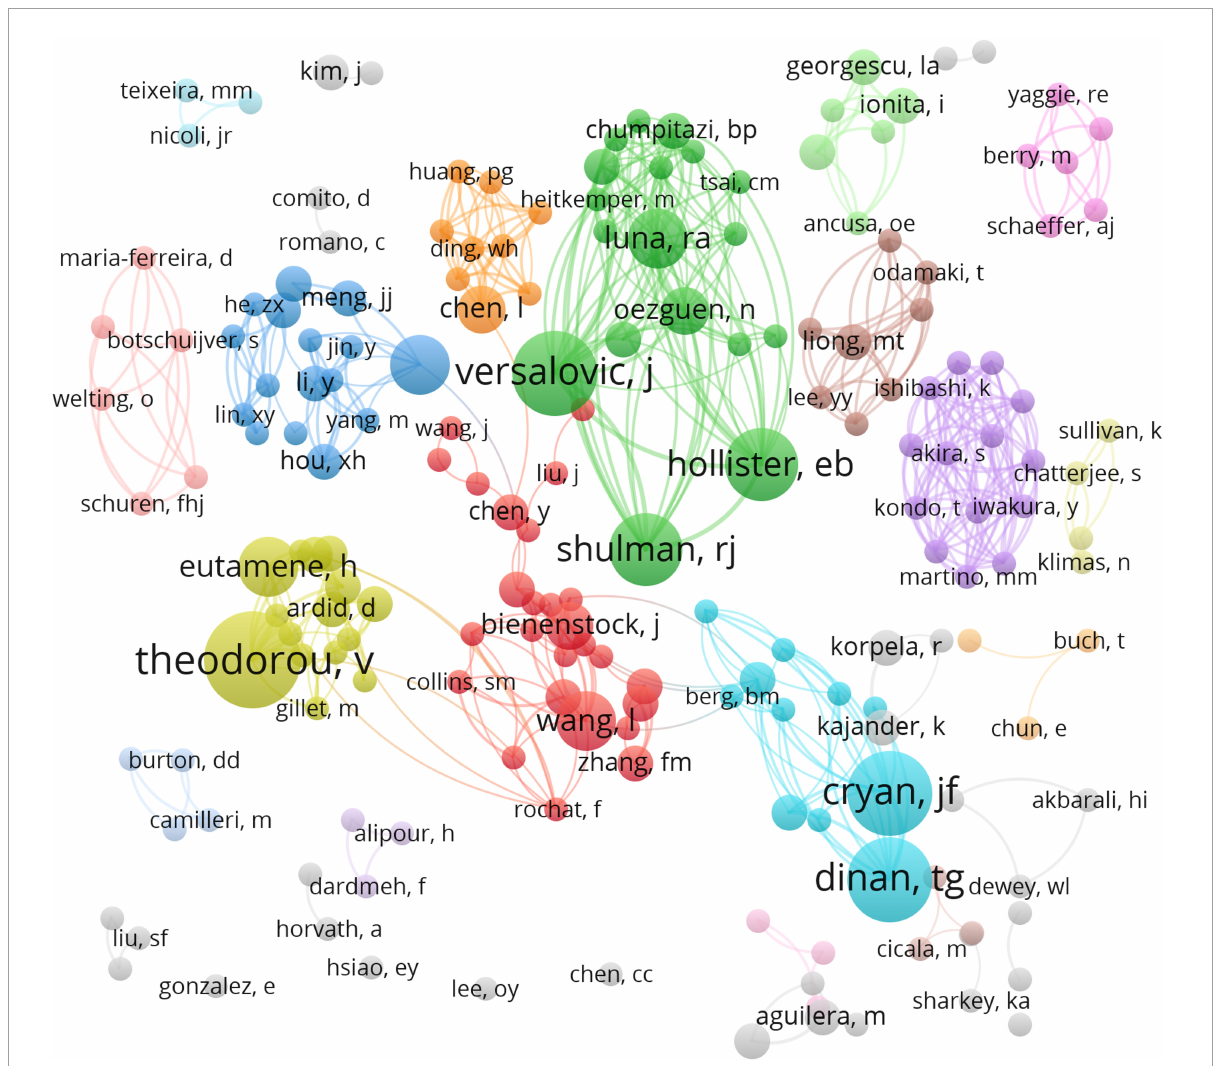
FIGURE4 VOSviewer network of authorship in research on the links between the gut microbiota and pain. Each circle represents an author and the link between the two circles means a collaboration between each